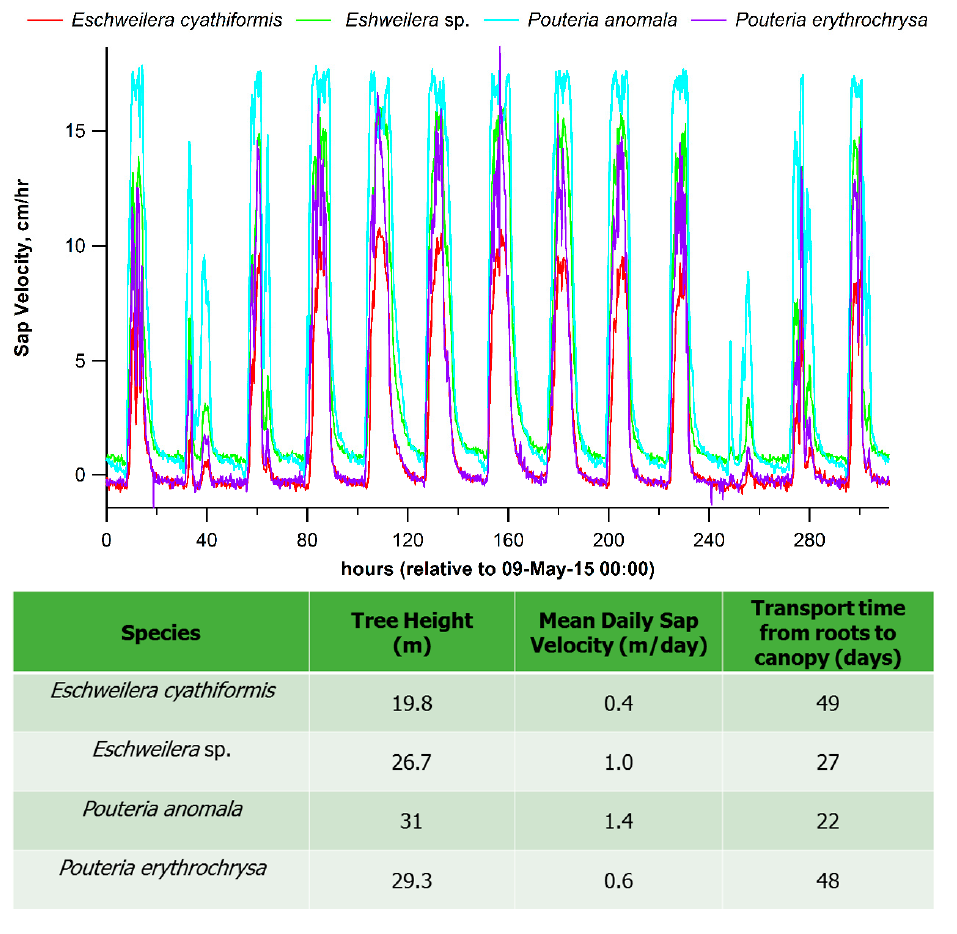
Figure 2. Real-time sap velocities of 4 trees in an undisturbed mature tropical forest in the central Amazon during a 12-day dry season period (5–21 May 2015). Also shown in the table below are calculated transport times required for root-derived ABA to reach the top of the canopy via the transpiration stream.